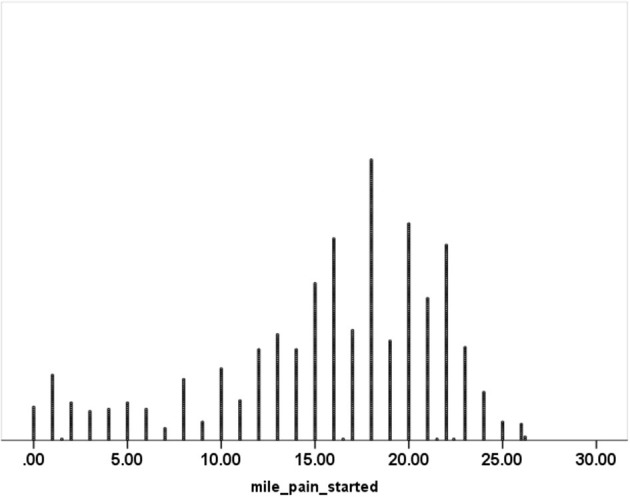
Frequency distribution of the mile at which pain was first experienced during a marathon.